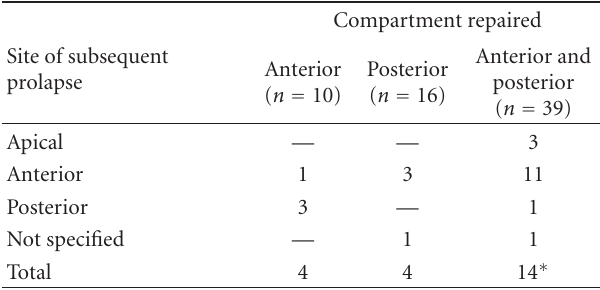
Table 3: Site of recurrence or subsequent prolapse according to the compartment repaired.